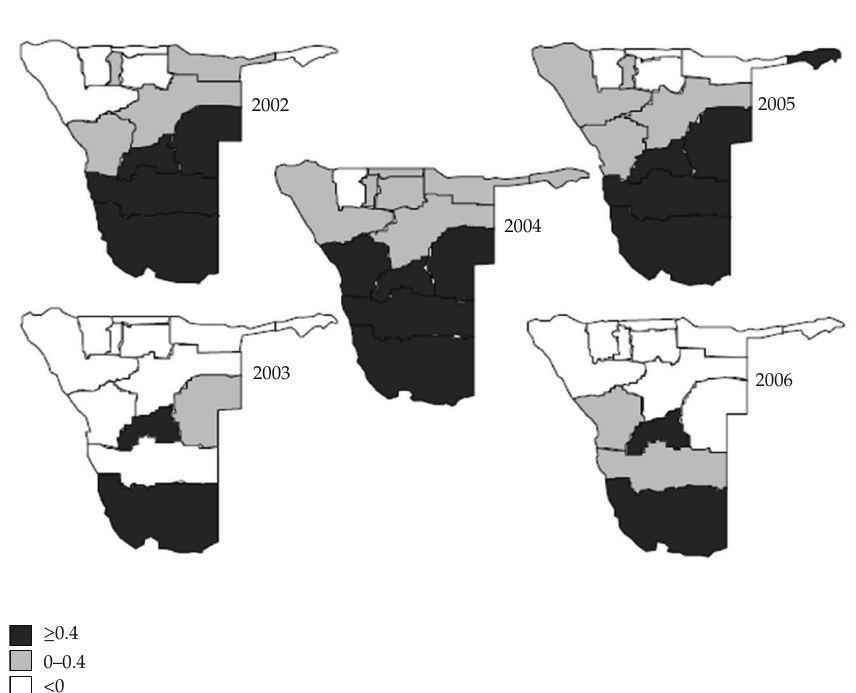
Figure 2: Distribution of the posterior mean value for the space-time structured heterogeneity (cid:5) u rt (cid:6) onto study